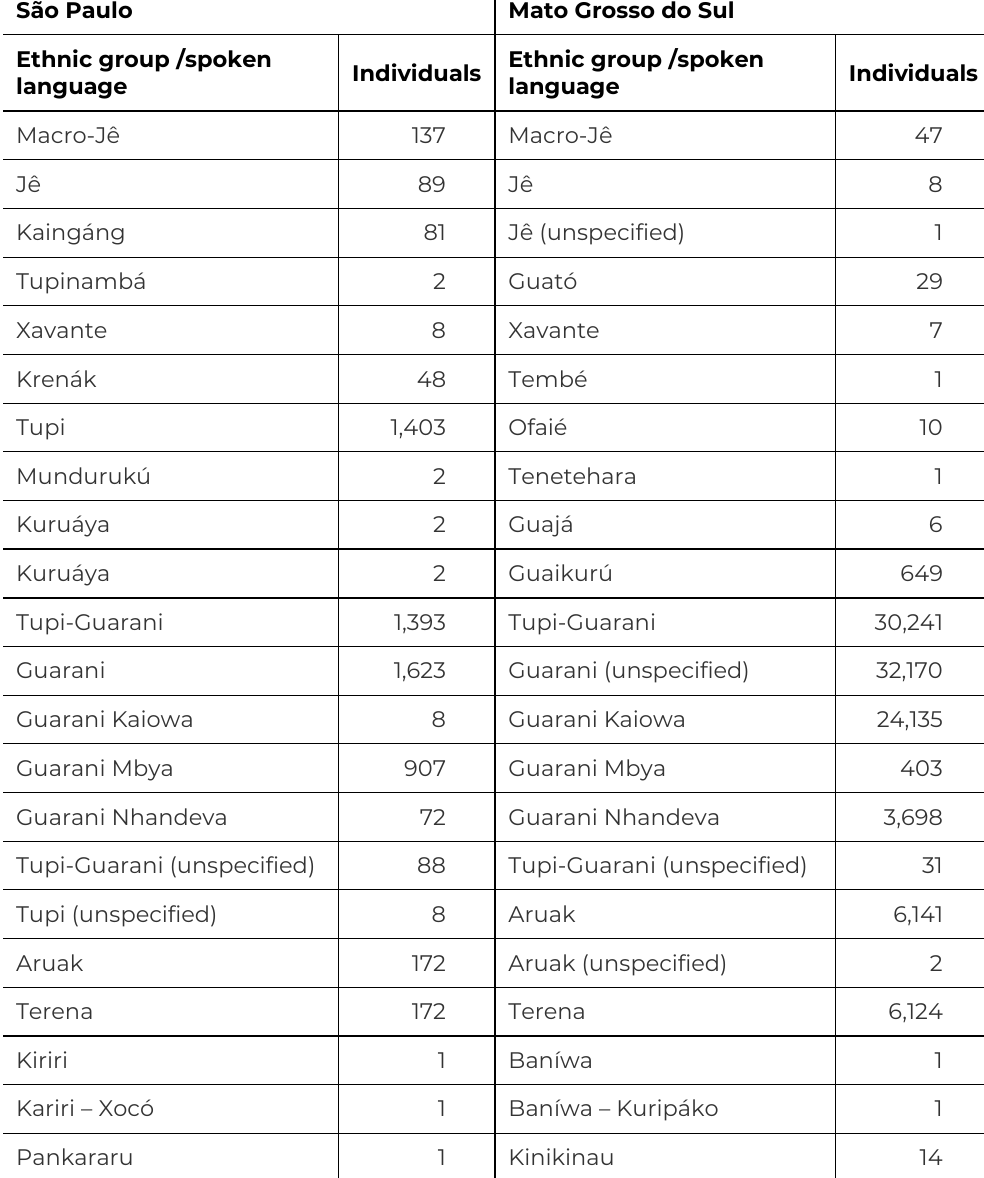
Table 3. Indigenous peoples and ethnic population in São Paulo and Mato Grosso do Sul (individuals five years of age or older who self-declared as indigenous) São Paulo Mato Grosso do Sul Ethnic group /spoken Individuals language